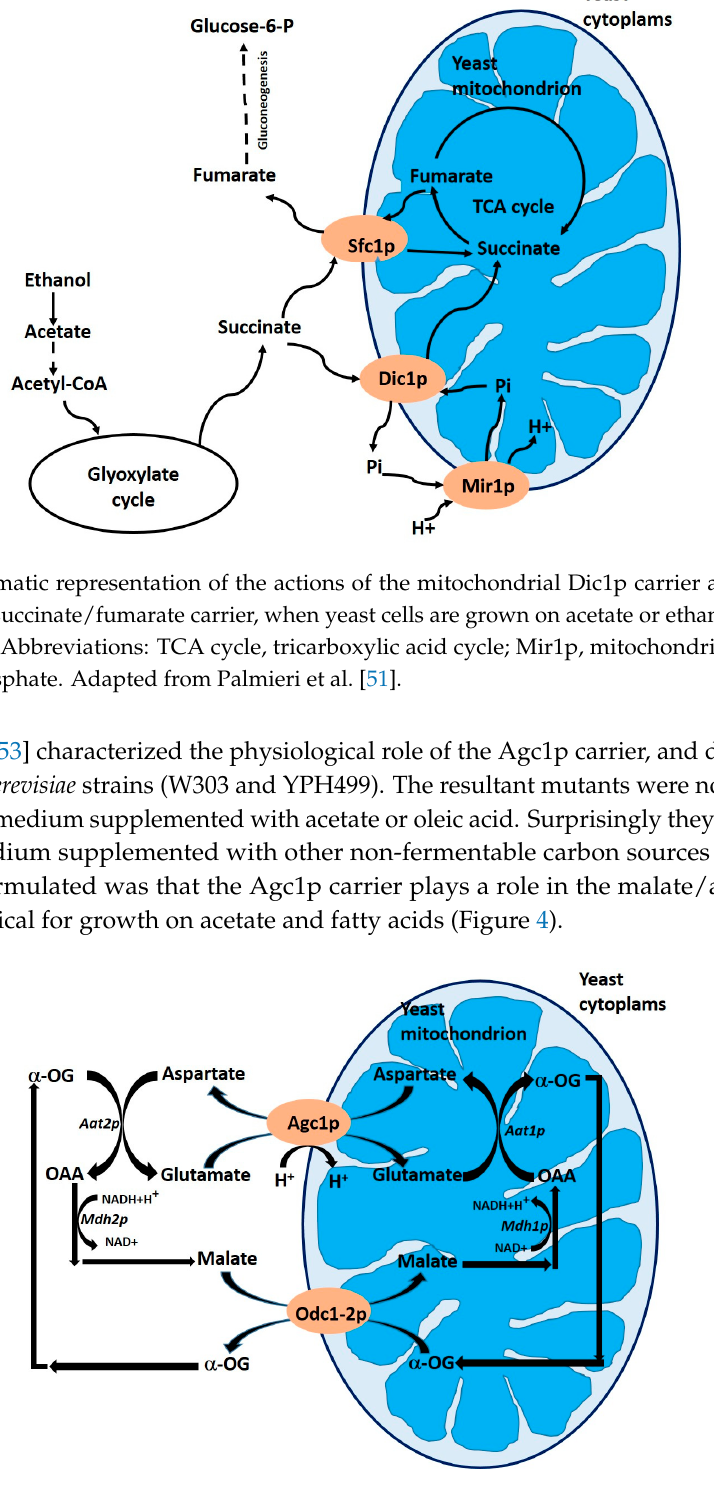
Figure 4. Schematic representation of the role of oxodicarboxylate Odc1p and Odc2p and mitochondrial aspartate/glutamate Agc1p carriers in the malate/aspartate transport system. Abbreviations: Aat1p, mitochondrial aspartate aminotransferase; Aat2p, cytosolic aspartate aminotransferase; Mdh1p, mitochondrial malate dehydrogenase; Mdh2p, cytosolic malate dehydrogenase; α -OG, 2-oxoglutarate; OAA, oxaloacetate. Adapted from Palmieri et al. [51].